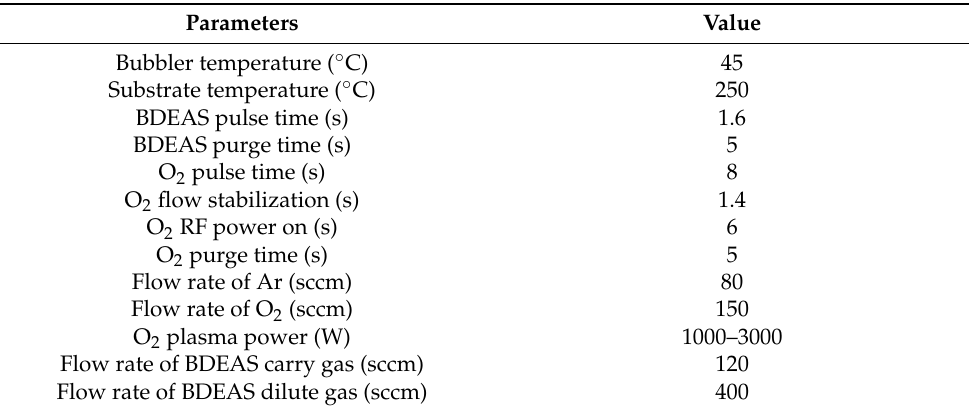
Table 1. Deposition parameters of RP-ALDSiO 2 thin